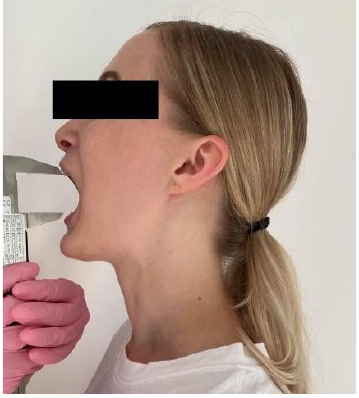
Figure 2. Mouth opening